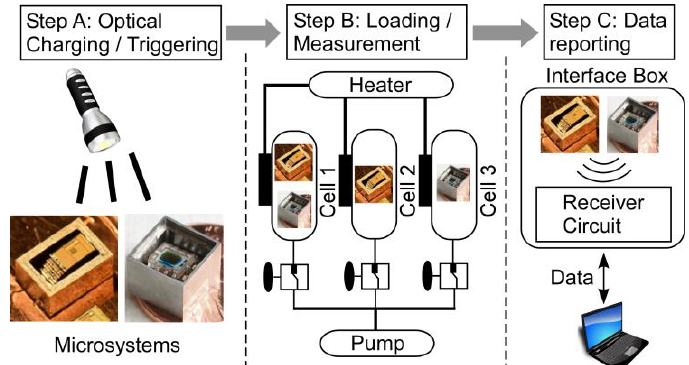
Figure 5. The testing procedure diagram. In Step A, the systems were charged and triggered into the detection state. In Step B, the systems were inserted into the testing cells with HPHT conditions. In Step C, the measured temperature data was reported wirelessly to a laptop through an interface unit.